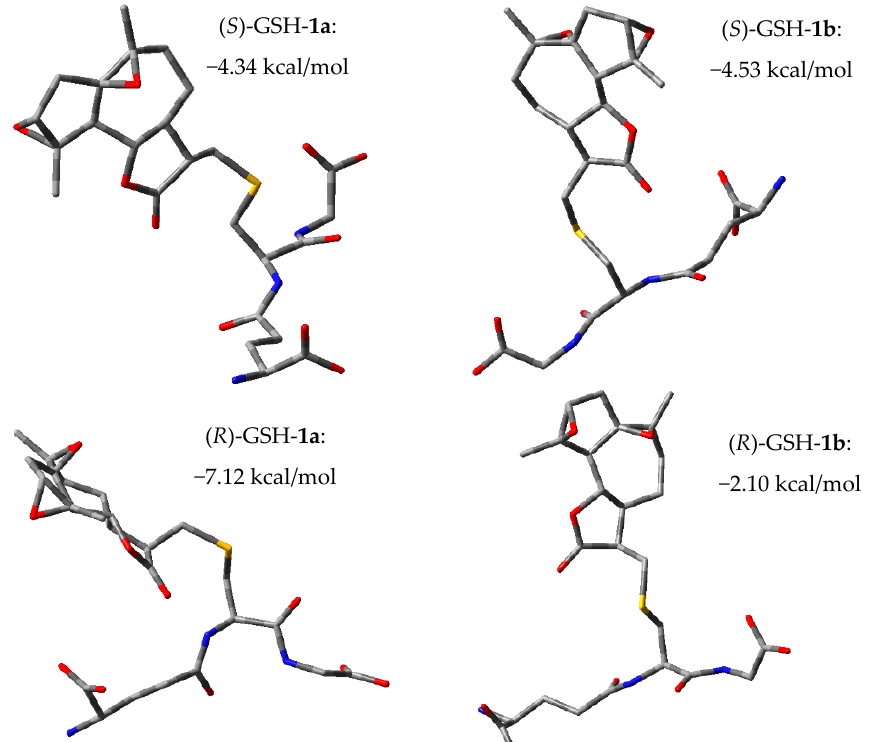
Figure 3. Molecular conformations and changes in Gibbs free energy calculated by the DFT method for the reaction products according to Scheme 1.